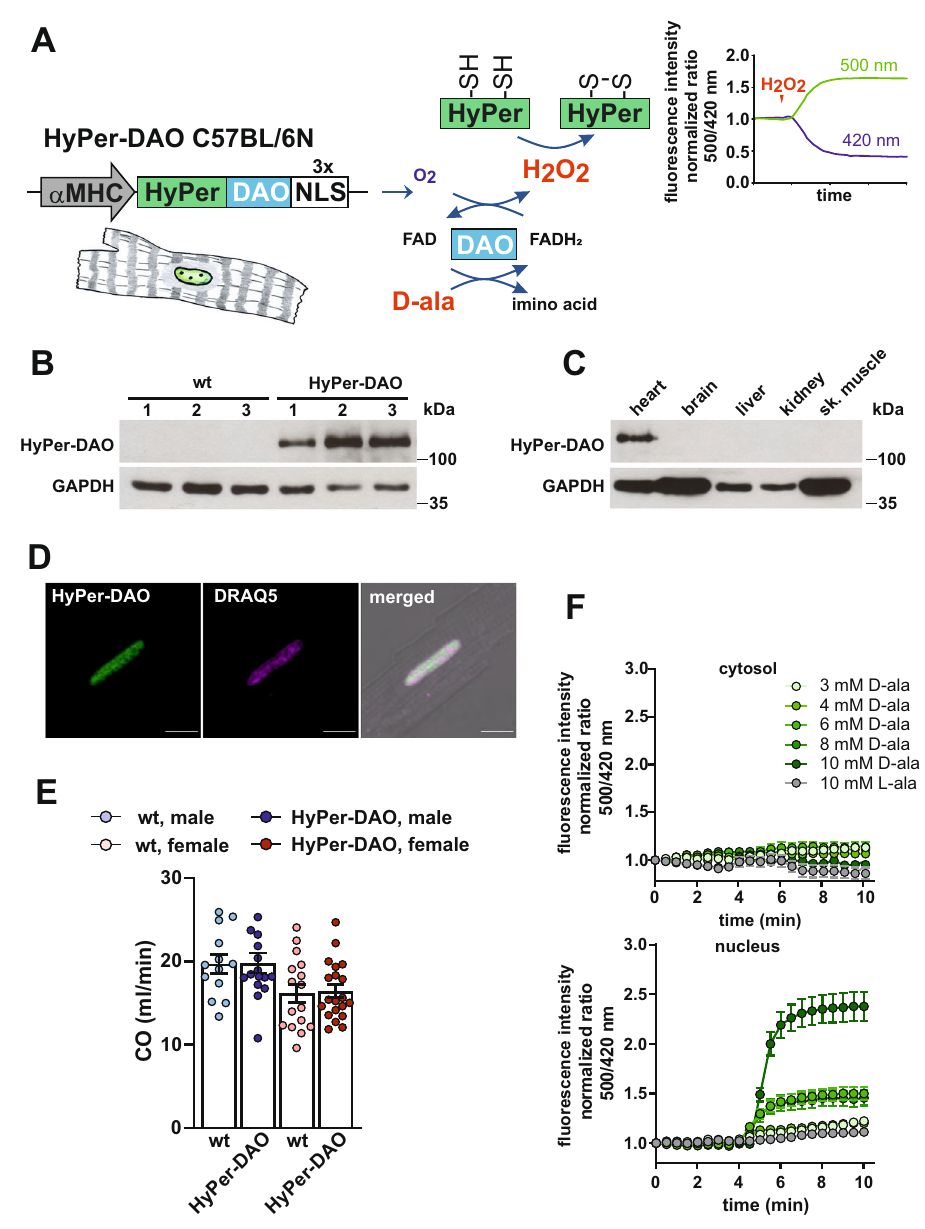
Fig. 1 | Expression and activation of the HyPer-DAO fusion protein in cardiomyocyte-speci fi c transgenic mice. A Scheme of the HyPer-DAO construct used for generating HyPer-DAO cardiomyocyte-speci fi c transgenic mice and the HyPer and DAO chemical reactions. B Immunoblot for HyPer-DAO and GAPDH proteinlevels in cardiacprotein lysatesfrom three independent wild type (wt) and three independent HyPer-DAO mice. C Cardiac-speci fi c HyPer-DAO protein expression in a HyPer-DAO mouse as demonstrated by immunoblot performed with proteinlysates from different organs. This con fi rmatory experiment hasbeen performed once. D Representative confocal image of a DRAQ5 stained cardio- myocyte isolated from a HyPer-DAO mouse. In total cardiomyocytes from two independent mice were isolated and 5 cardiomyocytes per mouse were imaged. E Cardiac output (CO) as determined by echocardiography in resting male and